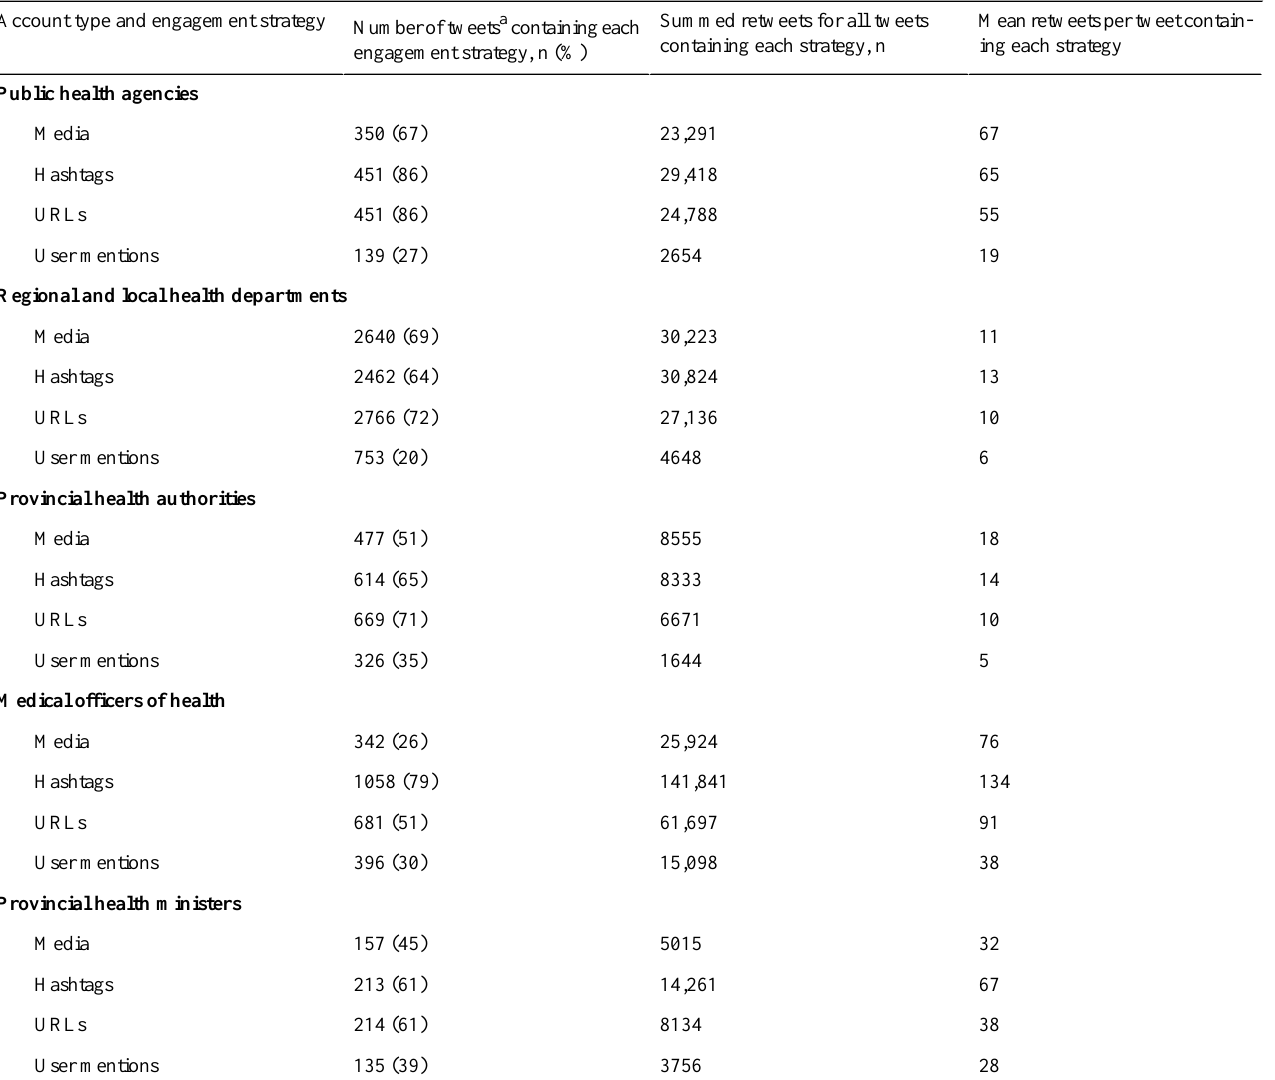
Table 2. Summed tweet (n=6982) and retweet frequencies and percentages by engagement strategy and account type, January 1, 2020, to June 30, 2020. (%)Account type and engagement